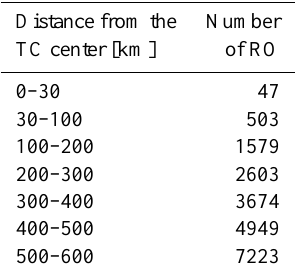
Figure 1. Exemplary tropopause altitude distribution vs. latitude during the Northern Hemisphere winter (a) and summer (b) . Table 1. Number of RO profiles co-located with TCs within increas- ing distance from the center of the